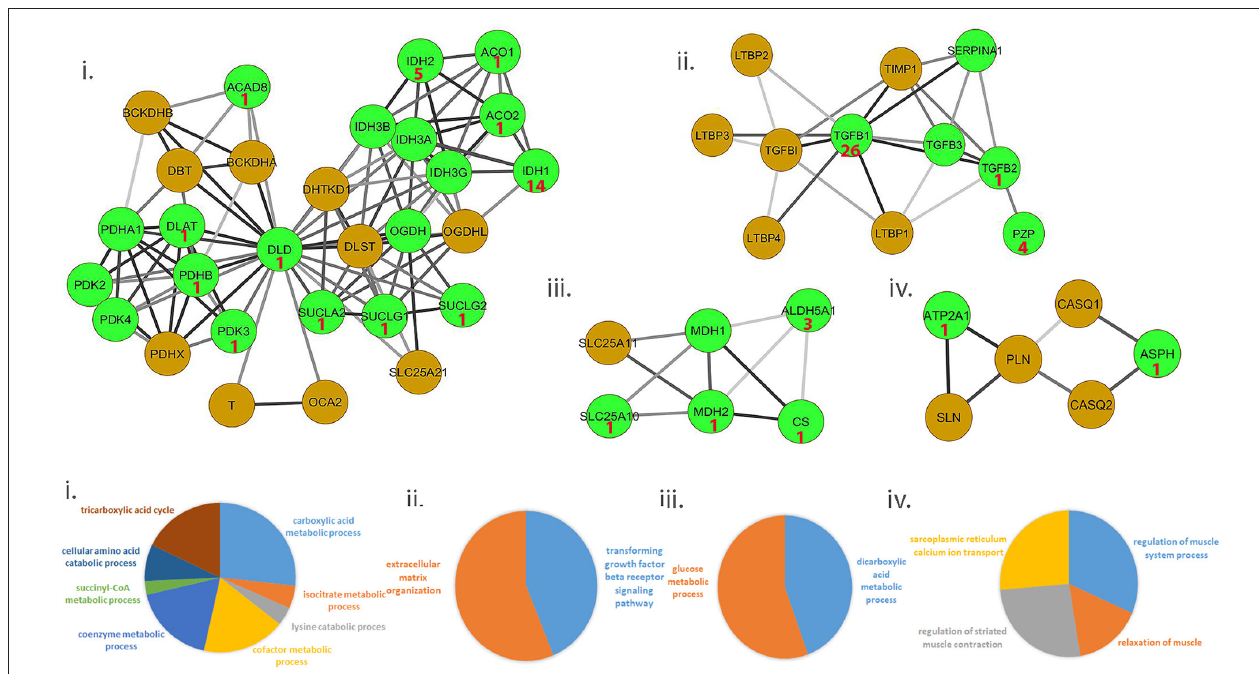
FIGURE 3 | Representative set of the protein signature modules underlying diseases affecting the muscle. Top panel (i–iv) represents 4/17 protein signature modules identified. The green nodes represent proteins that contain at least one interaction as defined in the Drug-gene interaction database (DGIdb). Number shown in the nodes represent the number of approved drugs targeting the proteins. Lower panel (i–iv) represents functional enrichment (top group terms) identified for the corresponding modules panel (i–iv) in the top panel, using ClueGO (see Methods). All 17 modules identified are presented in Figure S2.